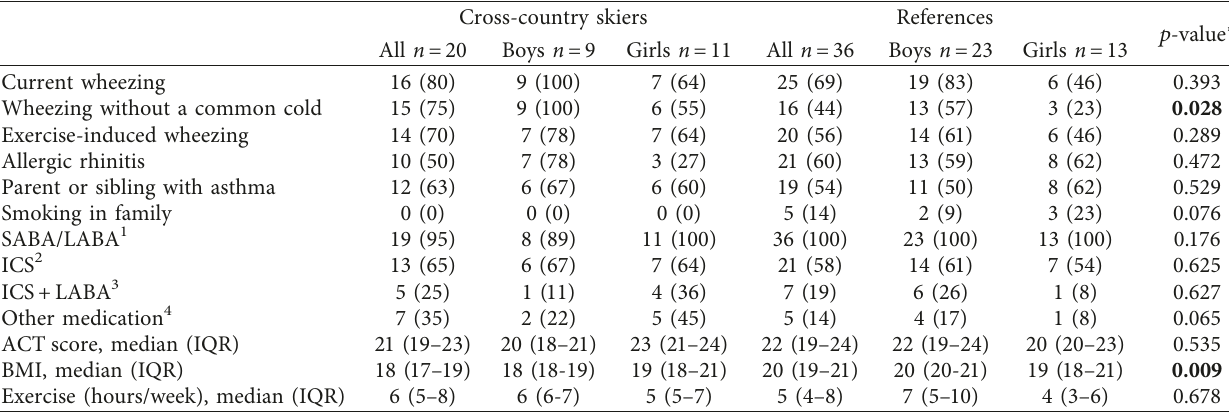
Table 2: Comparison between subjects with self-reported asthma among Swedish cross-country skiers in early adolescence and in a population-based reference